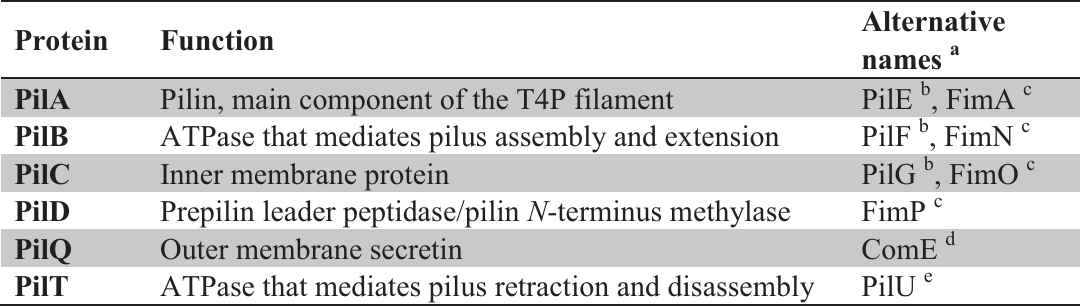
Table 1. Core components of T4P structure and function according to the Pseudomonas aeruginosa nomenclature. Some of the alternative names of homologous proteins in other bacteria are also